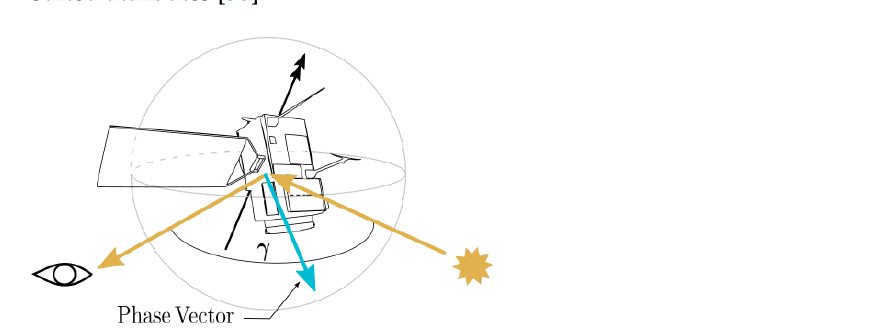
Figure 15. Projection of observations into a target’s body frame based on the direction of the phase